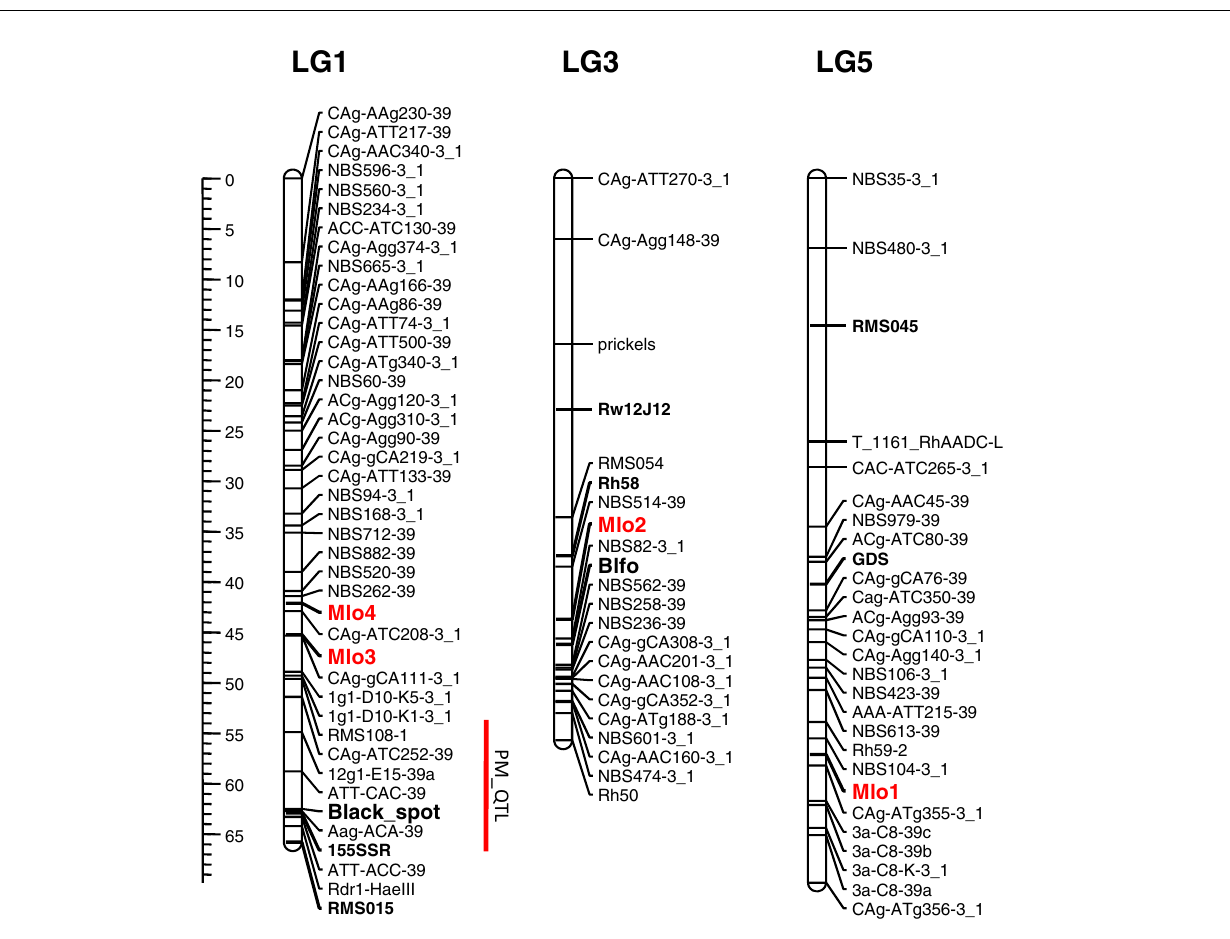
et al., 2011) are indicated in bold.The rose MLO genes are indicated in red. A powdery mildew QTL mapped in Linde et al., 2006 is indicated by a red bar right to linkage group 1.The plots were generated using MapChart 2.1 (Voorrips, 2002).